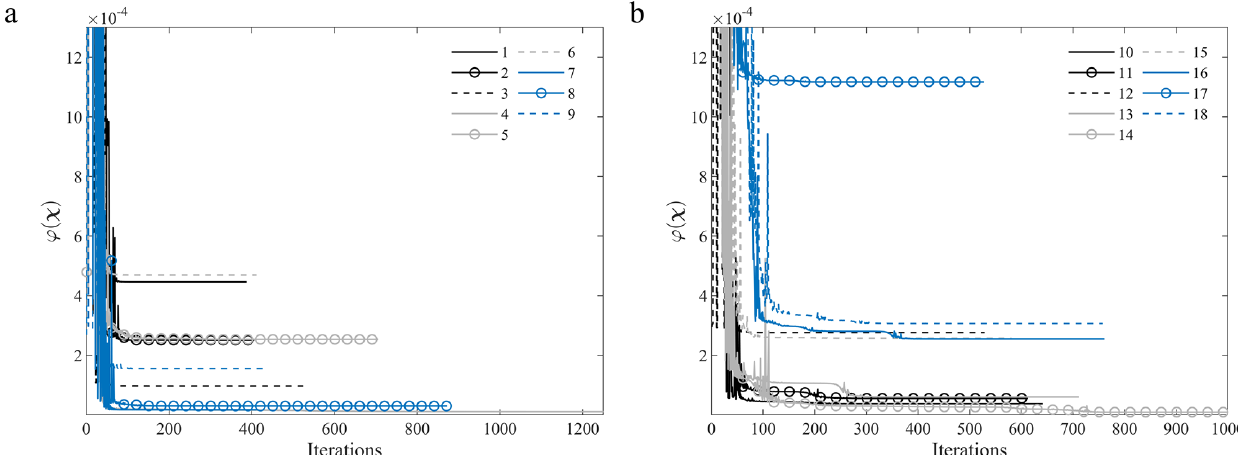
Figure 8. Convergence of the OF value during the identification process for: ( a ) On-axis (1–9) specimens and ( b ) Off-axis (10–18)